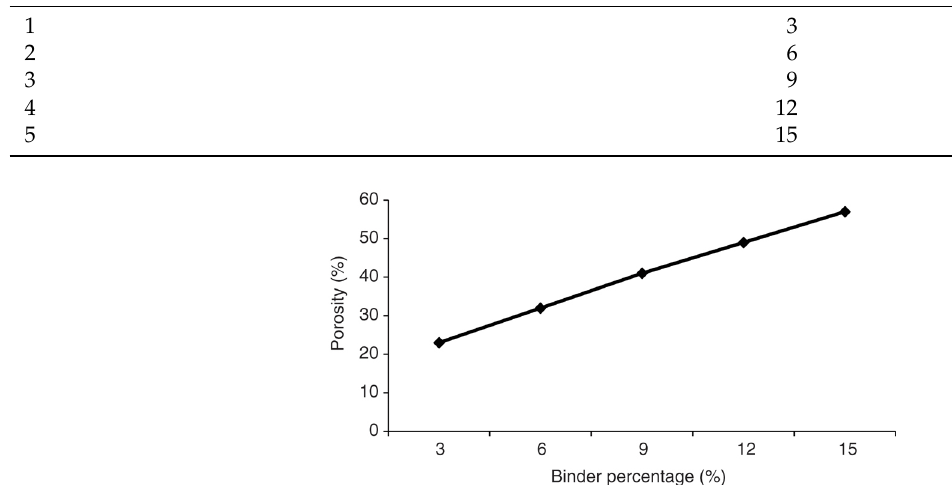
Table 3: Variation of porosity with the binder percentage. S. No.